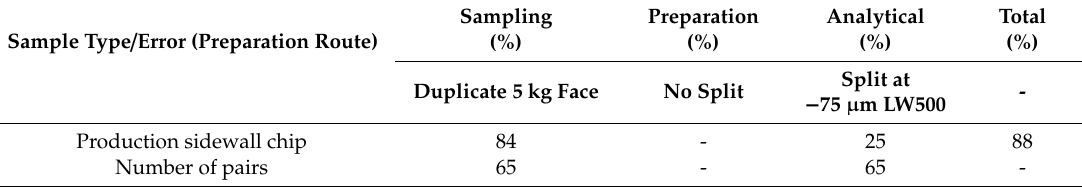
Table 32. Production sidewall chip sample duplicate pair